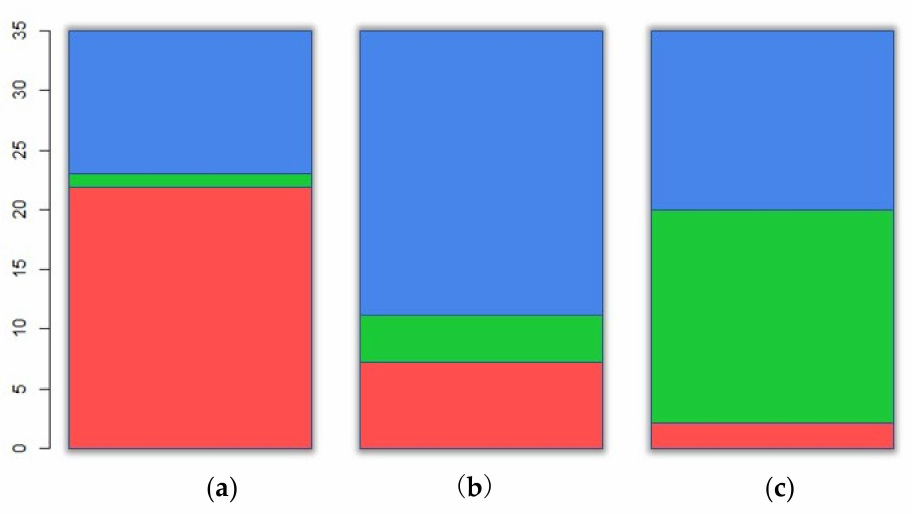
Figure 7. Result of the clustering analysis for scenario 8 in number of stations of each cluster: ( a ) rural;